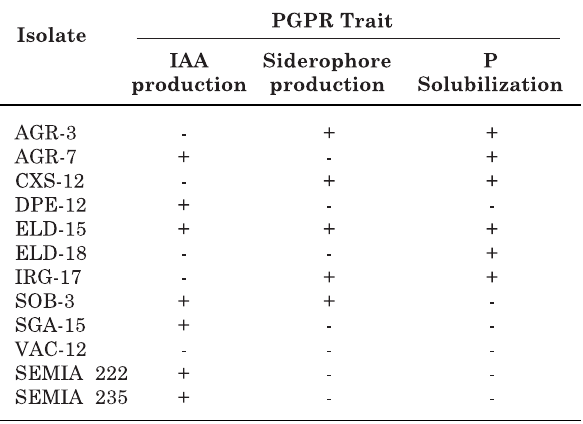
Table 2. Plant growth-promoting characteristics of selected rhizobial isolates and reference strains